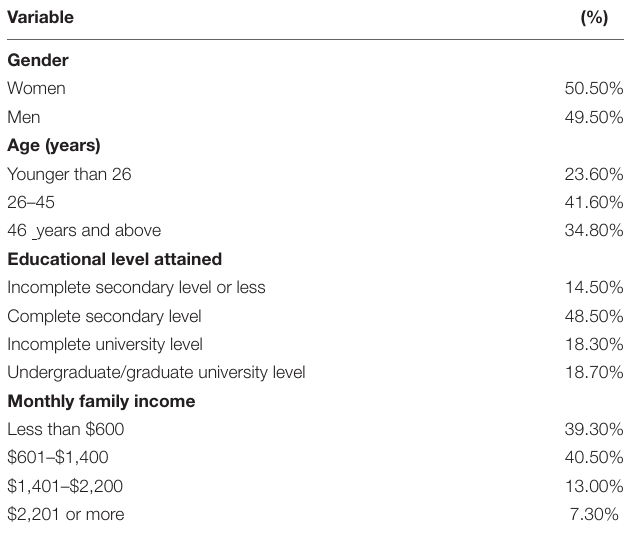
TABLE 2 | Sample characteristics ( N = 771).